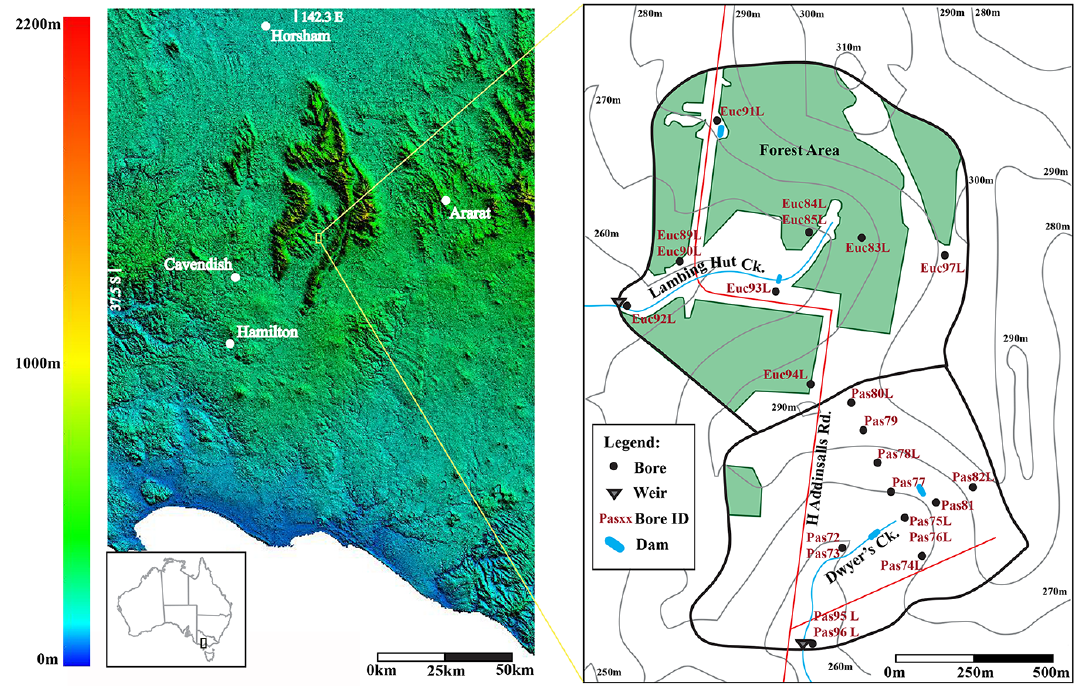
Figure 1. Left: location of the study site in southwestern Victoria, Australia; right: location of the streams, weirs and bores and their reference numbers. “L” denotes the presence of a water level logger in a